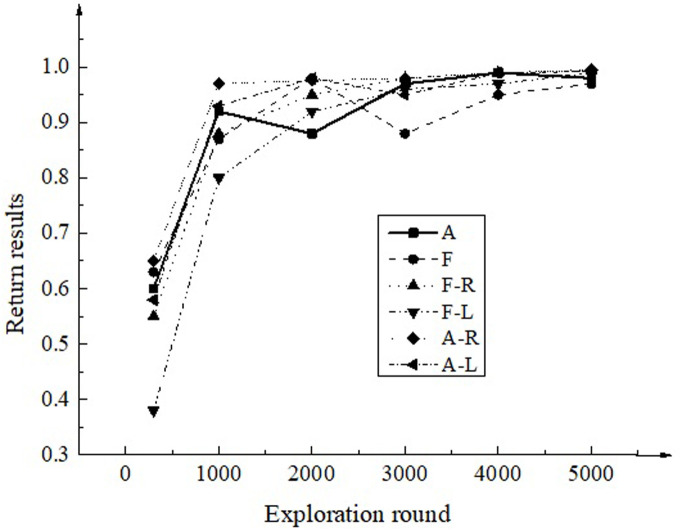
Performance test results of M-DDPG algorithm under 6 tasks (A represents backward action state, F represents forward, F-R represents forward-right turn, F-L represents forward-left turn, A-R represents backward-right turn, A-L represents backward-left turn).